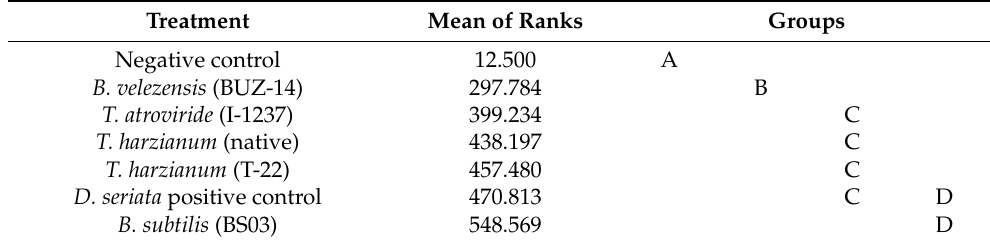
Table 3. Kruskal–Wallis test and multiple pairwise comparisons using the Conover–Iman procedure for the lengths of the vascular necroses for D. seriata